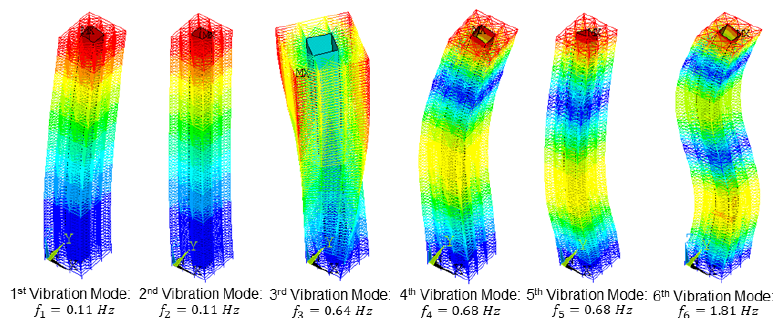
Figure 3. 1 st to 6 th tall building vibration mode without